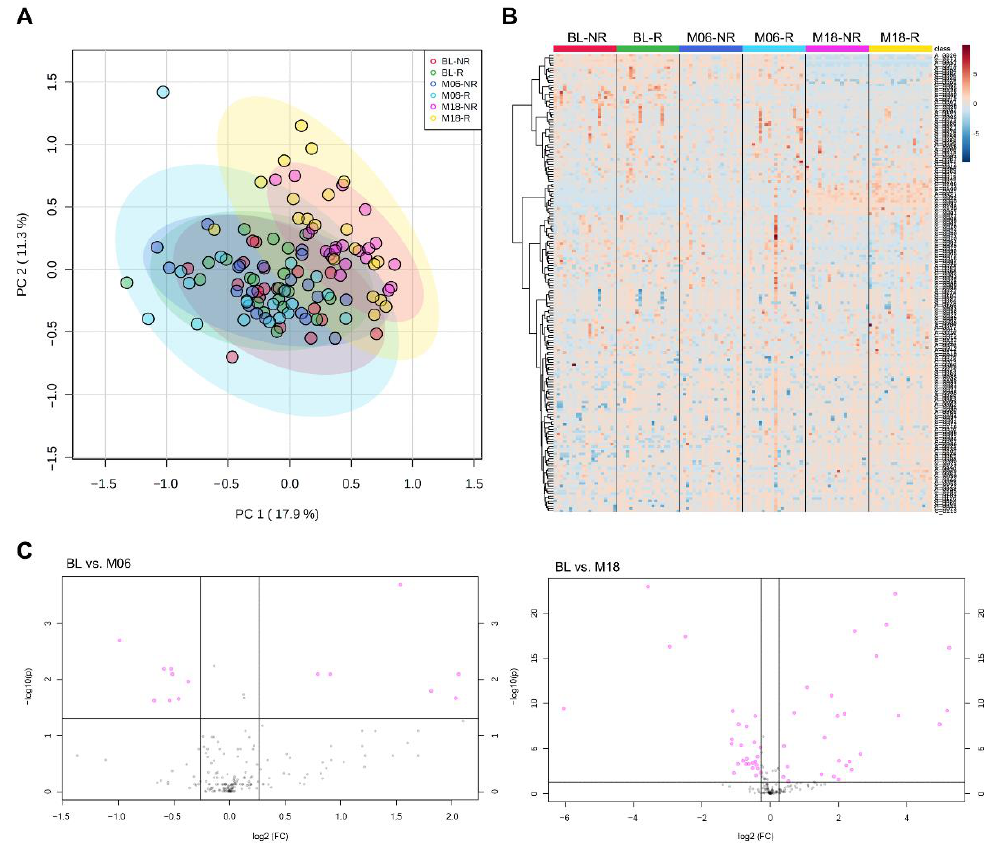
Figure 1. Plasma metabolome profiles of the study population. ( A ) Principal component analysis and ( B ) hierarchical cluster analysis showing time-dependent metabolic changes by weight-loss interventions rather than responsiveness to the intervention. ( C ) Volcano plots of significant metabolites (FDR adjusted p -value < 0.05, fold change > 1.2) at 6 months and 18 months post-intervention compared to baseline.